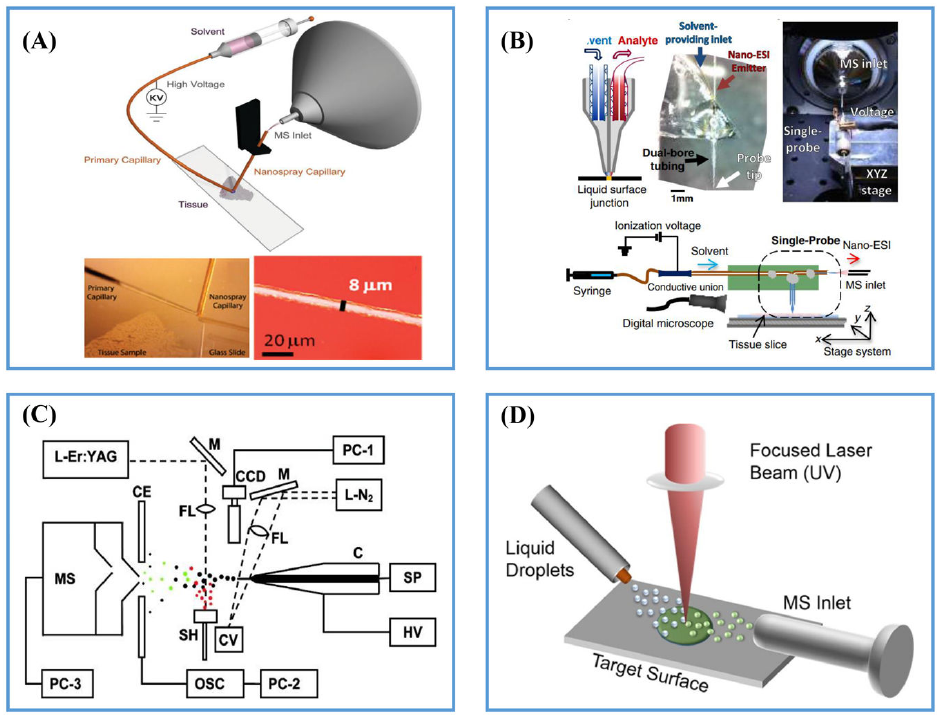
Figure 3. ( A ) Scheme of nano-DESI ion source. Reprinted with permission from the authors of [57]. Copyright (2012) American Chemical Society. ( B ) Scheme of single probe ion source. Reprinted with permission from the authors of [38]. Copyright (2015) American Society for Mass Spectrometry. ( C ) Scheme of LAESI ion source. Reprinted with permission from the authors of [41]. Copyright (2007) American Chemical Society. ( D ) Scheme of LDIDD ion source. Reprinted with permission from the authors of [56]. Copyright (2016) American Chemical